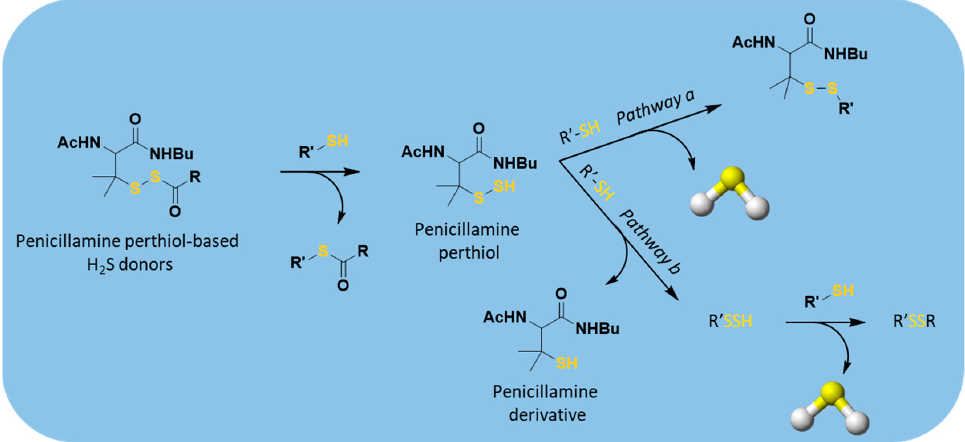
Figure 10. Proposed mechanism of H 2 S release from perthiol-based donors; R’-SH = cysteine or GSH. H 2 S release from penicillamine-derived perthiol donors was also studied in vivo and in cardiac myocytes (H9c2 cells), confirming their ability to release. Moreover, the selected donors were evaluated into a murine model of myocardial I/R injury. The results proved that they exhibit cardioprotective activity due to their ability to reduce the infarct size.